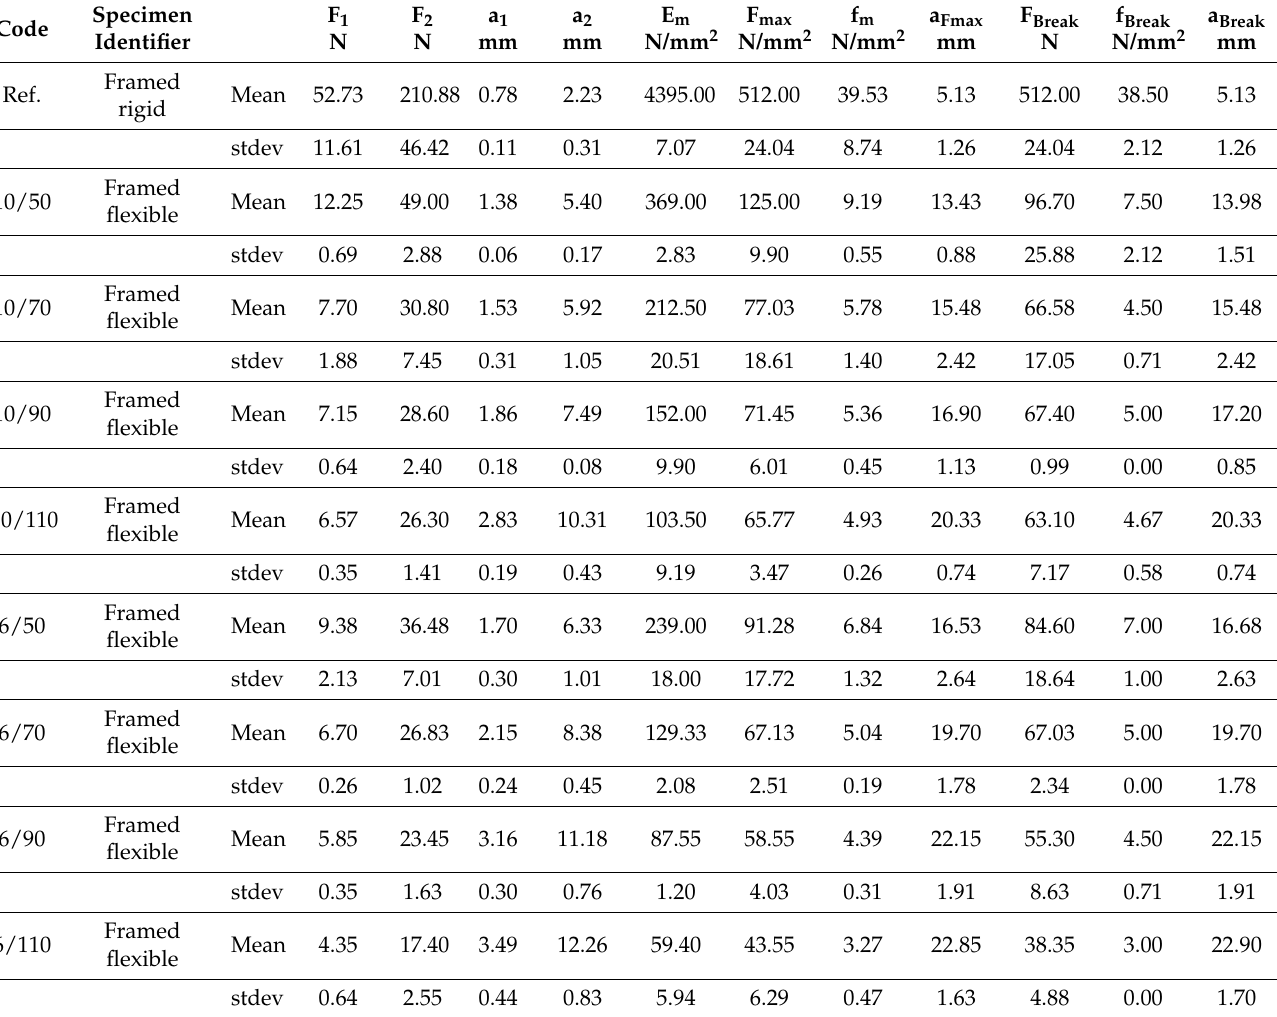
Table 3. Results of static bending (mean values and standard deviation) for reference-framed rigid and framed flexible samples kerfed with two pitch values (6 and 10 mm) and four flexibilization lengths (50, 70, 90, and 110